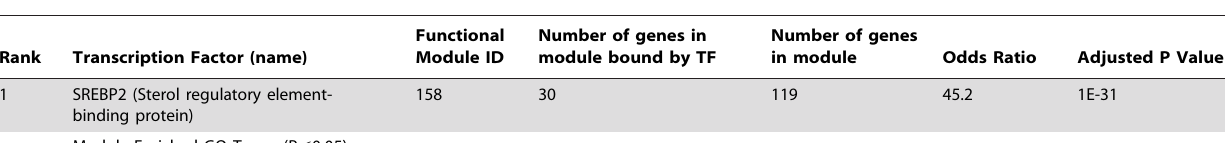
Table 1. Functional modules recapitulate known transcription factor